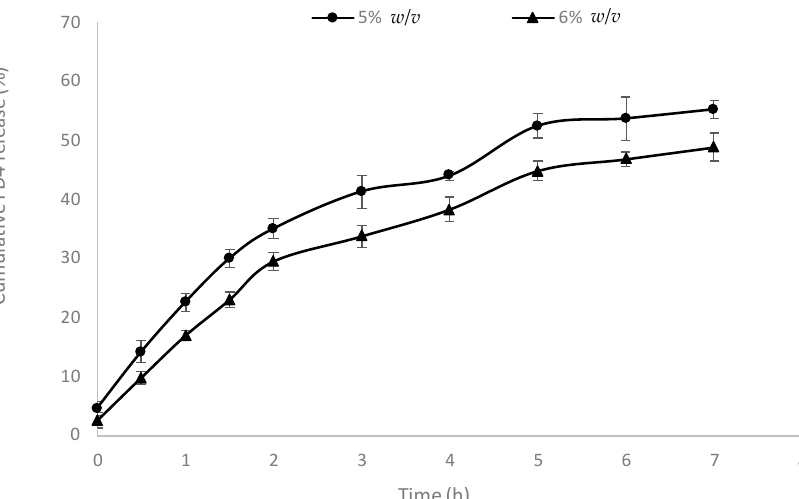
Figure 3. Drug release profile of ascorbyl palmitate hydrogel. Drug release was tested in Hank’s Balanced Salt Solution at room temperature. Data shown as mean ± SD ( n = 3).